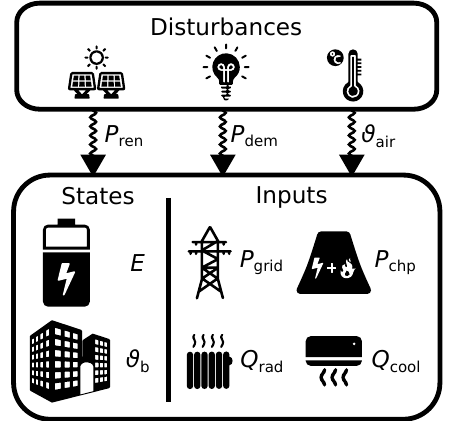
Figure 1. Illustration of the microgrid’s components.